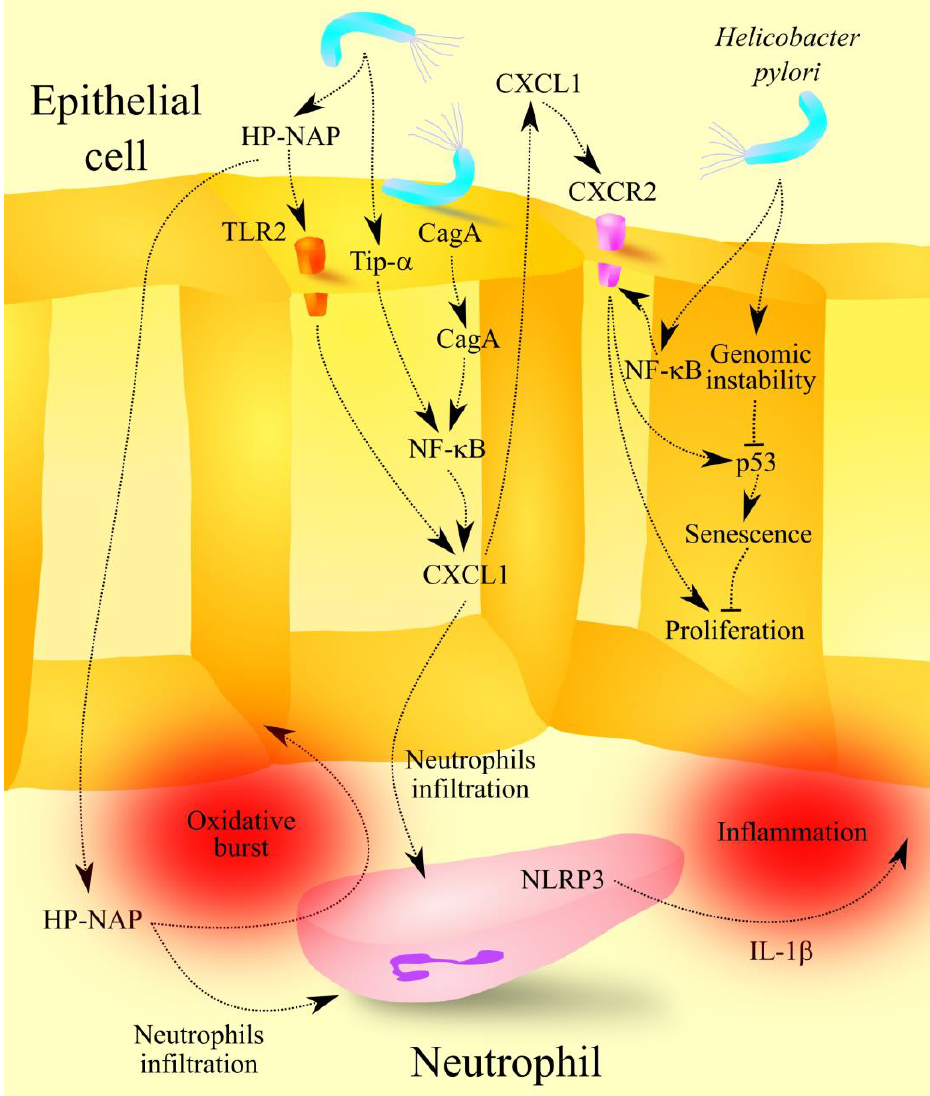
Figure 3. The role of CXCL1 in the molecular mechanisms of H. pylori infection. H. pylori increases CXCL1 expression in the epithelial cells of gastric mucosa due to virulence factors Tip- α, HP -NAP and CagA, which activate NF- κB and TLR2. Then, CXCL1 and HP -NAP cause infiltration of the gastric mucosa by neutrophils. These cells cause chronic inflammation through the secretion of IL- 1β and ROS. CXCL1 also causes senescence of gastric mucosa by activating the CXCR2 receptor and increasing p53 activity. This process leads to gastric mucosal atrophy. At the same time, by activating NF- κB, H. pylori increases CXCR2 expression and thus sensitizes cells to CXCL1 activity. H. pylori – induced senescence is a state in which cell proliferation is inhibited. On the other hand, H. pylori also causes genomic instability, which leads to mutations in the TP53 gene. This reduces the activity of the product of this gene: p53. Because CXCR2 activation also causes inactivation of p53, it leads to the proliferation of gastric mucosa cells and the formation of gastric cancer associated with H. pylori infection. Abbreviations: CagA — cytotoxin-associated gene A; CXCL1CXC motif chemokine ligand 1; CXCR2 — CXC motif chemokine receptor 2; HP-NAP — H. pylori -neutrophil activating protein; IL- 1β— interleukin- 1β; NF - κB—nuclear factor κB; NLRP3— nucleotide-binding domain and leucine-rich repeat related family, pyrin domain containing 3; Tip- α— TNF- α inducing protein; TLR2— toll-like receptor 2. Source: own elaboration.